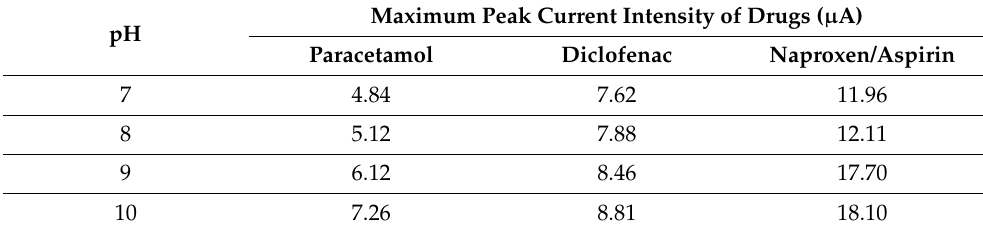
Table 1. Study of current intensities at different pH for a mixture of